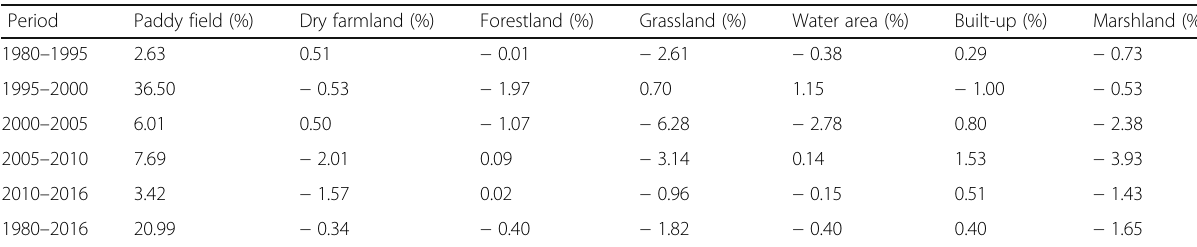
Table 3 Single land use dynamic degree